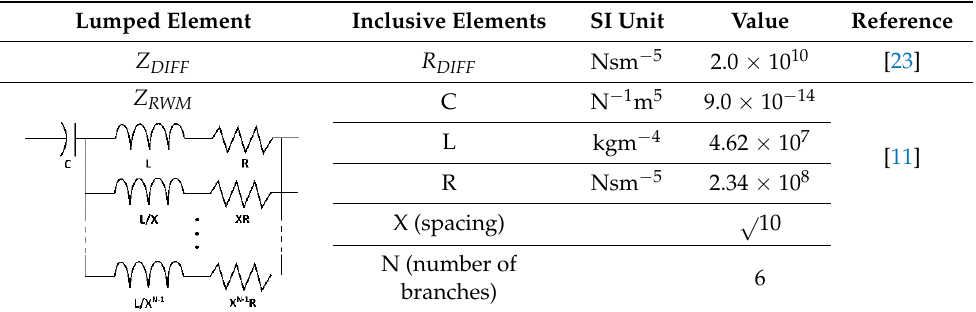
Table 1. Parameter values used in Nakajima et al.’s lumped element model (LEM). Lumped Element Inclusive